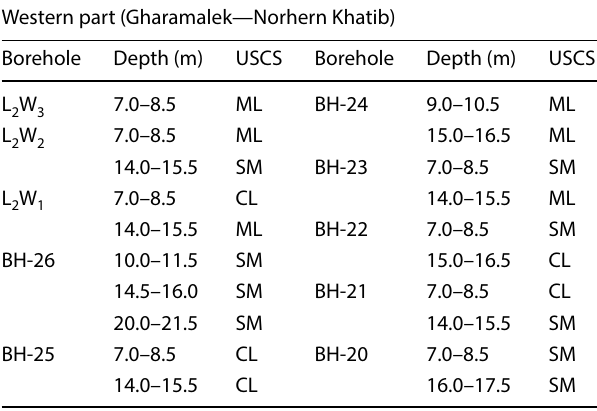
Table 2 Geotechnical specifications of alluvial layers at different depths in the western part of TML2 Western part (Gharamalek—Norhern Khatib) Borehole Depth